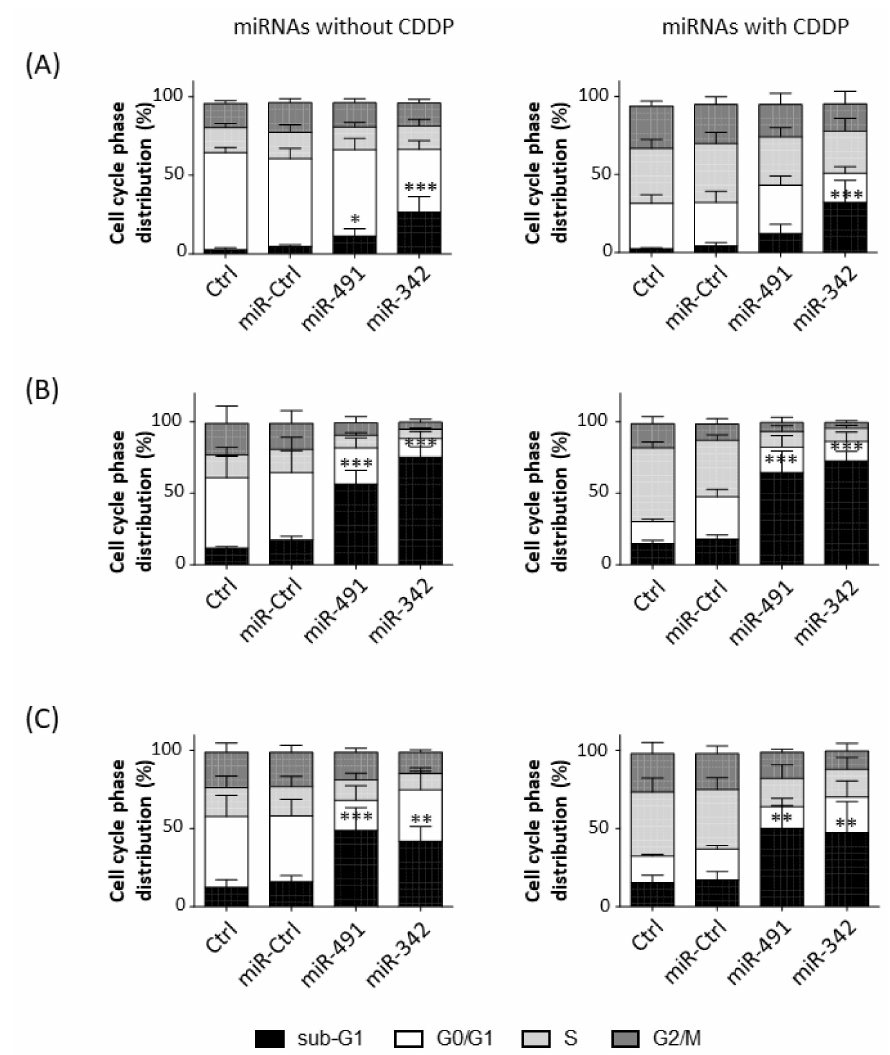
Figure 3. Evaluation of cytotoxic or chemosensitizing effects of miR-491-5p and miR-342-5p on osteosarcoma cell lines. ( A ) HOS, ( B ) MG-63 and ( C ) SaOS-2 cells were cultured and transfected with miR-Ctrl, miR-491-5p and miR-342-5p as described in Figure 1. Flow cytometry was carried out 72 h after transfection to analyze cell cycle phase distribution. The histograms show the analysis of five independent experiments for HOS cells and four independent experiments for MG-63 and SaOS-2 cells (mean ± SD with the different phases of the cycle). Statistically significant differences in the percentage of sub-G1 events between miR-Ctrl and miRNA-treated cells are presented. They were determined using one-way ANOVA (***: p < 0.001, **: p < 0.01, *: p <